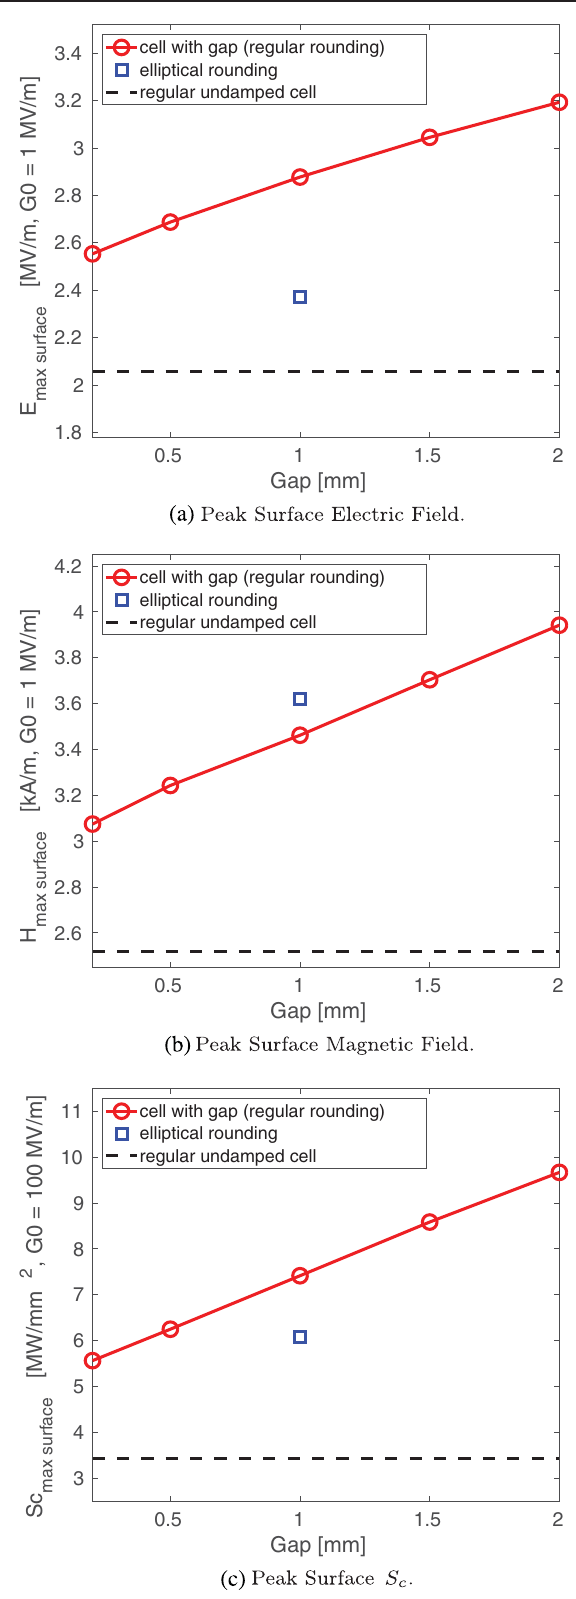
FIG. 3. Surface field simulations for the CLIC-G-OPEN design compared to the CLIC-G structure.